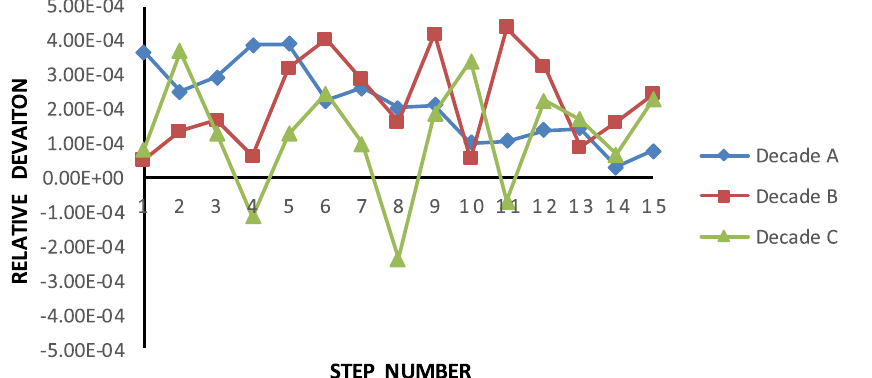
Fig. 5. Relative deviation of the output capacitance steps.